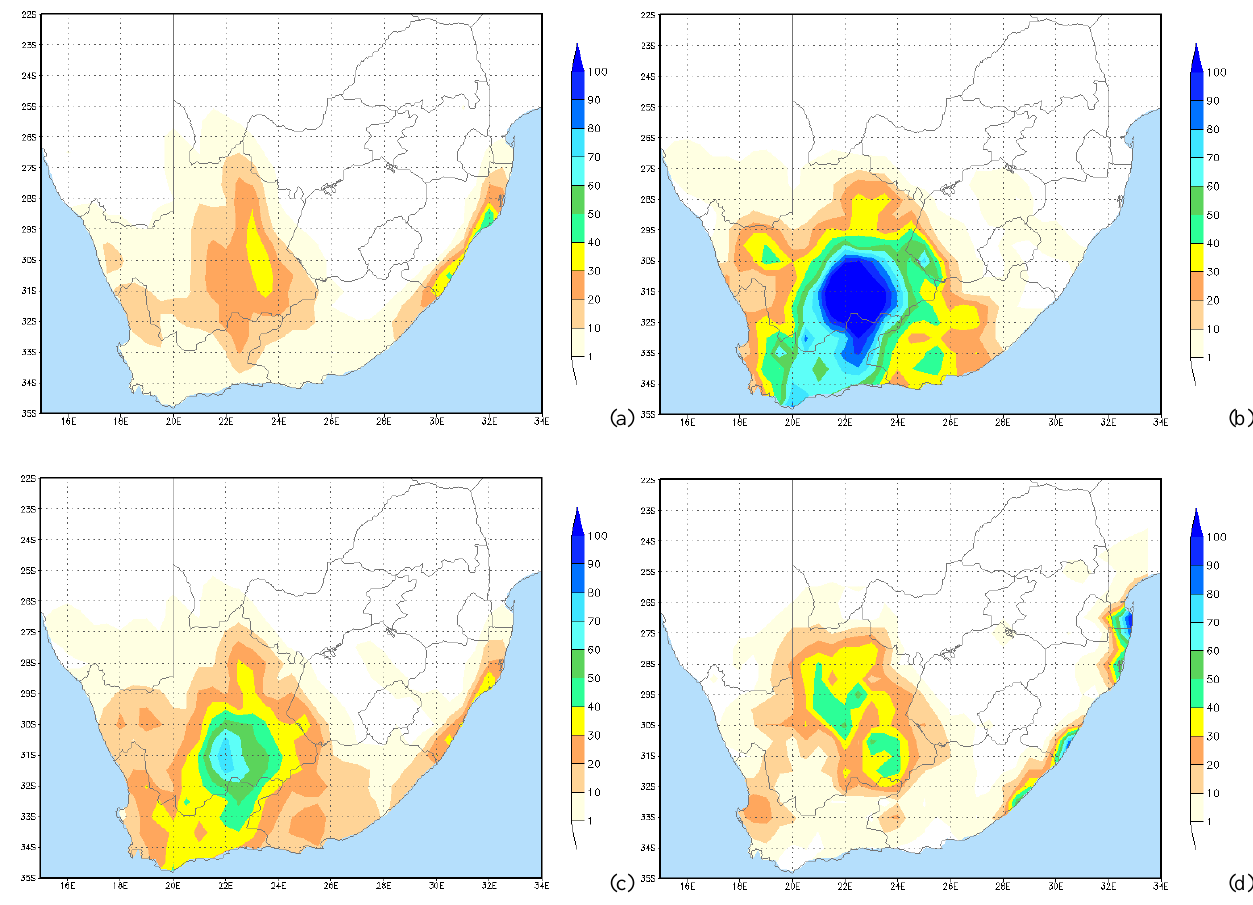
Fig. 14. Unified Model stratiform precipitation total for 24h (a) , Hydroestimator precipitation total for 24h (b) , the combined product from HE and UM for 24h (c) and the total rainfall as measured by the rain gauges (d) for 18 June